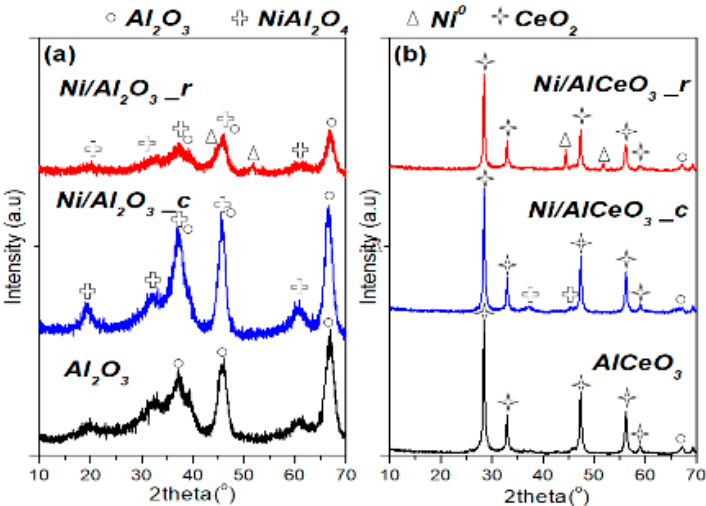
Figure 3. XRD patterns of supports, calcined and reduced catalysts: ( a ) Al 2 O 3 and Ni / Al 2 O 3 and ( b ) AlCeO 3 and Ni / AlCeO 3 .